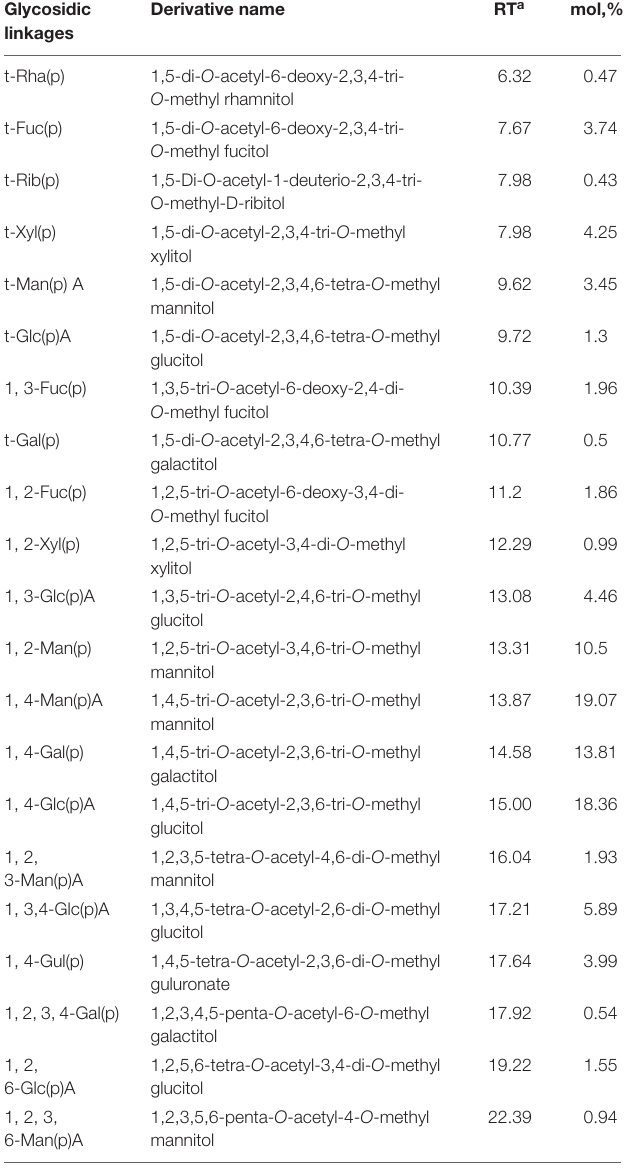
TABLE 3 | Glycosidic linkages among the monomer residues and molar proportions of LJPS. Glycosidic